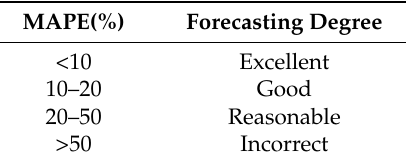
Table 2. Criterion of